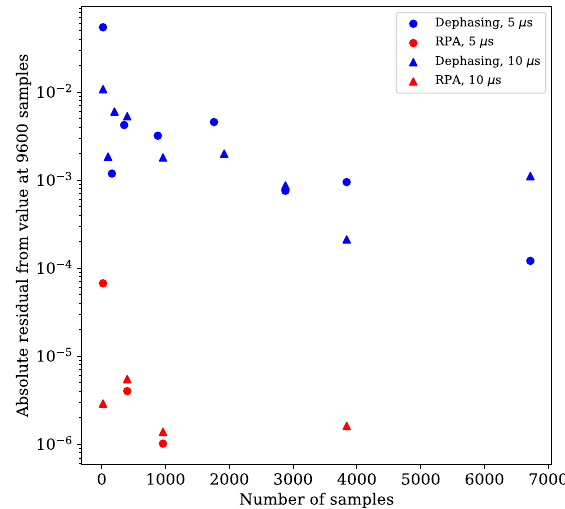
FIG. 8. We compare the sampling error obtained using both the random-phase-approximation method and the dephasing method, at a given number of samples, to that obtained at 9600 samples. We see that the RPA method rapidly converges to the value obtained at 9600 samples. While we are unable to bound the sampling error at 9600 samples, we see from Fig. 7 that the RPA method can obtain an accuracy of less than 10 − 3 for the 11-qubit system with 100 samples. Given that the sampling error decreases with both system size, and the number of samples,